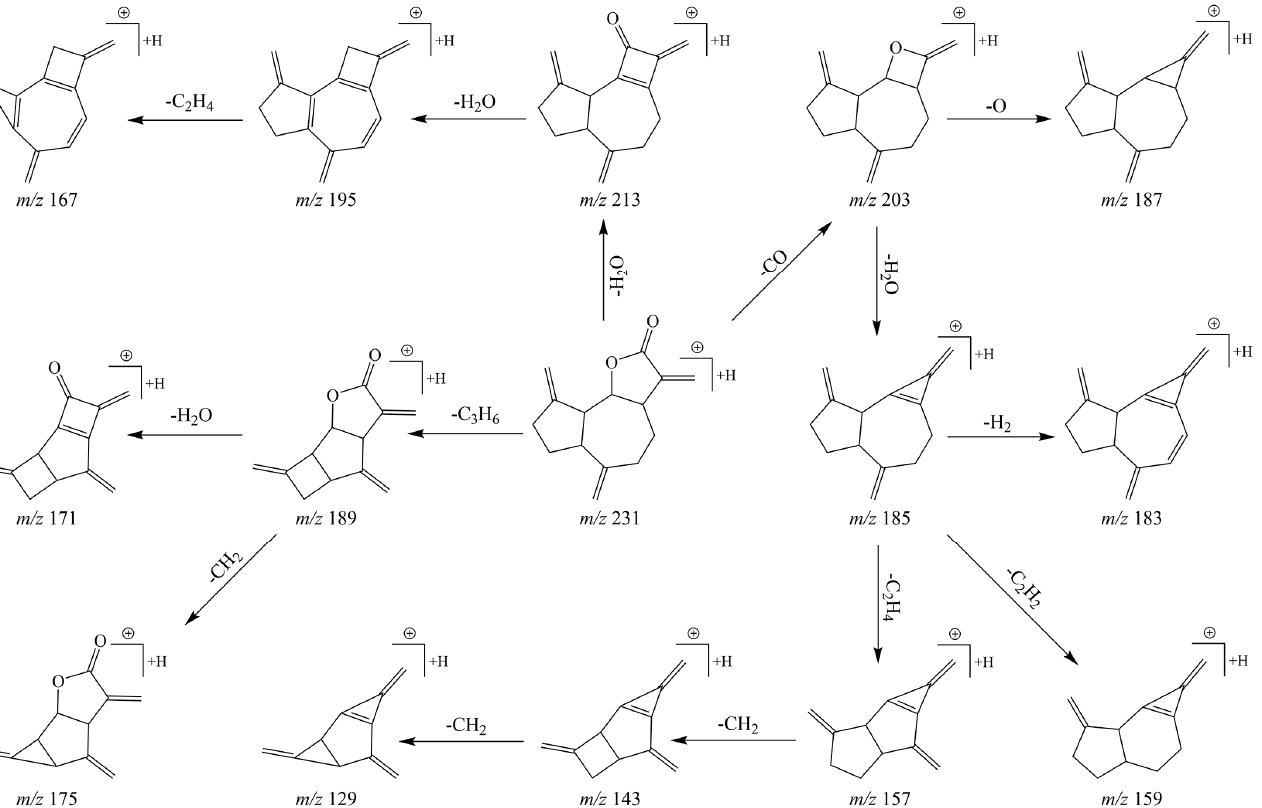
Figure 4. The proposed fragmentation pathways for DL.